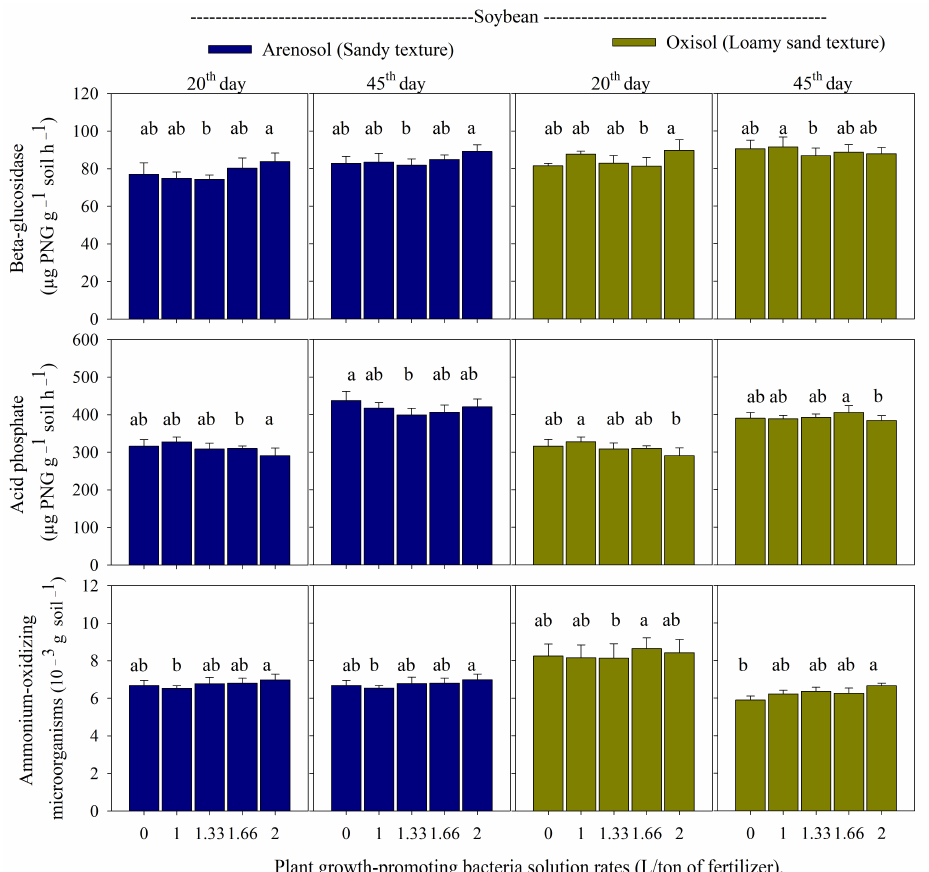
Figure 2. Beta-glucosidase, acid phosphatase, and ammonium-oxidizing microorganisms in an arenosol and oxisol cultivated with soybean and application of monoammonium phosphate sprayed with rates of plant growth-promoting bacteria solution (PGPB; 0; 1; 1.33; 1.66; and 2.0 L/ton of fertilizer), in the periods of 20 and 45 days after soybean emergence. Deviation bars indicate the standard error from the mean. Lowercase letters represent the comparison between treatments using the Duncan test ( p -value < 0.05). Control is the application of monoammonium phosphate without PGPB.